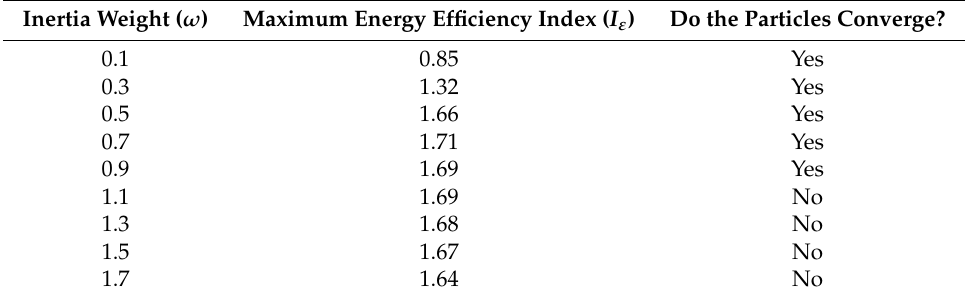
Table 1. Differences in the behavior of the algorithm according to the inertia weight parameter. Inertia Weight ( ω )